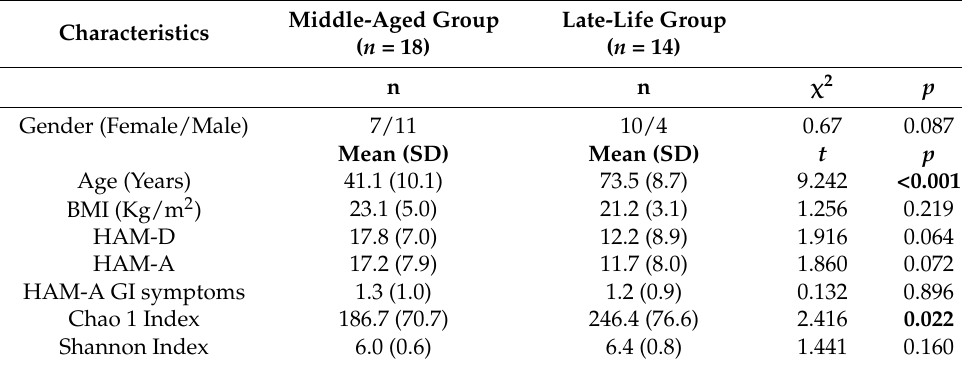
Table 1. Clinical characteristics of the included patients.